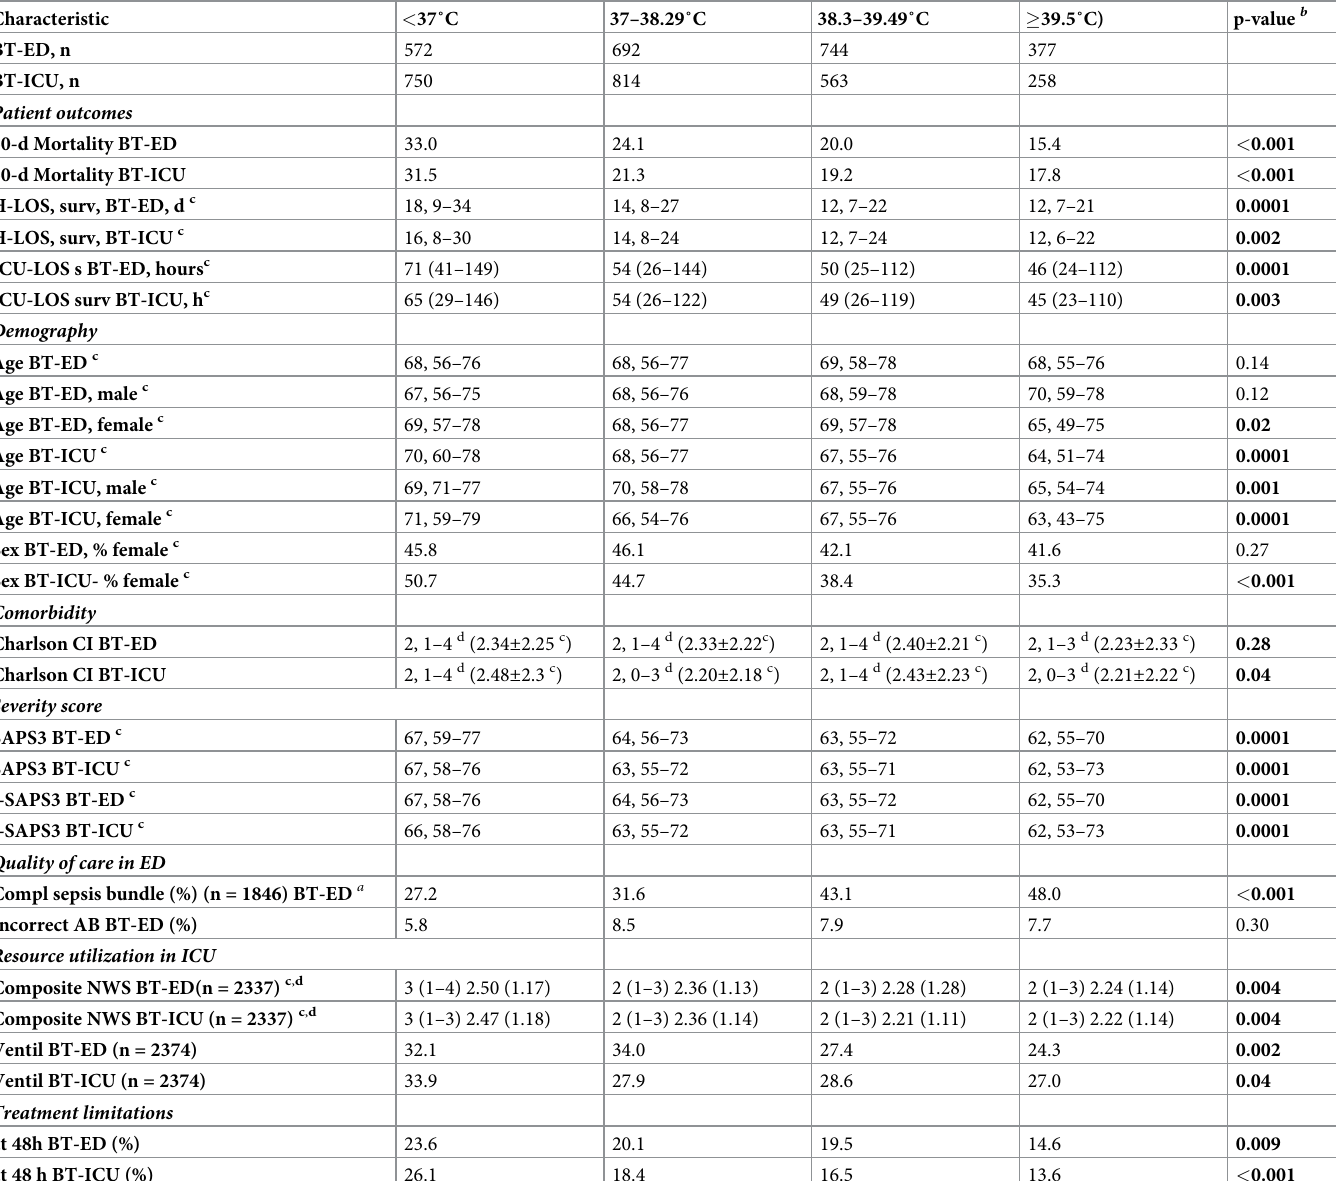
Table 1. Distribution of outcomes, demographic factors and risk factors for 30-day mortality by strata of temperature measured in the ED and in the ICU.